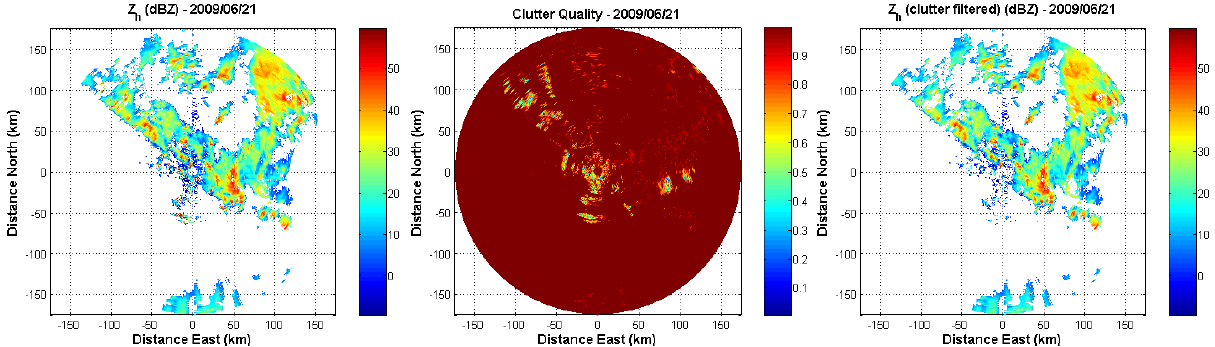
Fig. 4. Reflectivity Z measured by DPC radar “Il Monte”, on 21 June 2009, at 14:00UTC, elevation 0.4 (left); clutter quality map associated Fig.4: Reflectivity Z measured by DPC radar “Il Monte”, on June 21, 2009, at 14.00 UTC, with the image (centre); reflectivity image with clutter quality field applied ( q clutter < 0.6) elevation 0.4 (left); clutter quality map associated to the image (centre); reflectivity image with clutter quality field applied ( q < 0.6) (right). clutter